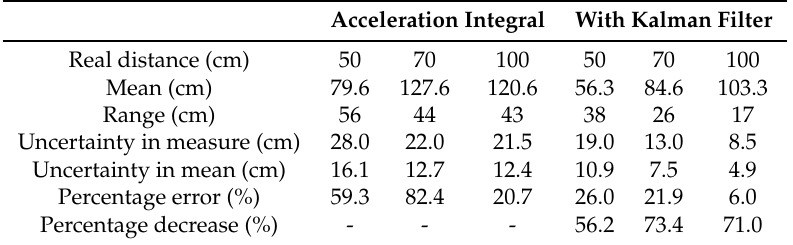
Table 3. Displacement along the xy-plane measured with the Waspmote.